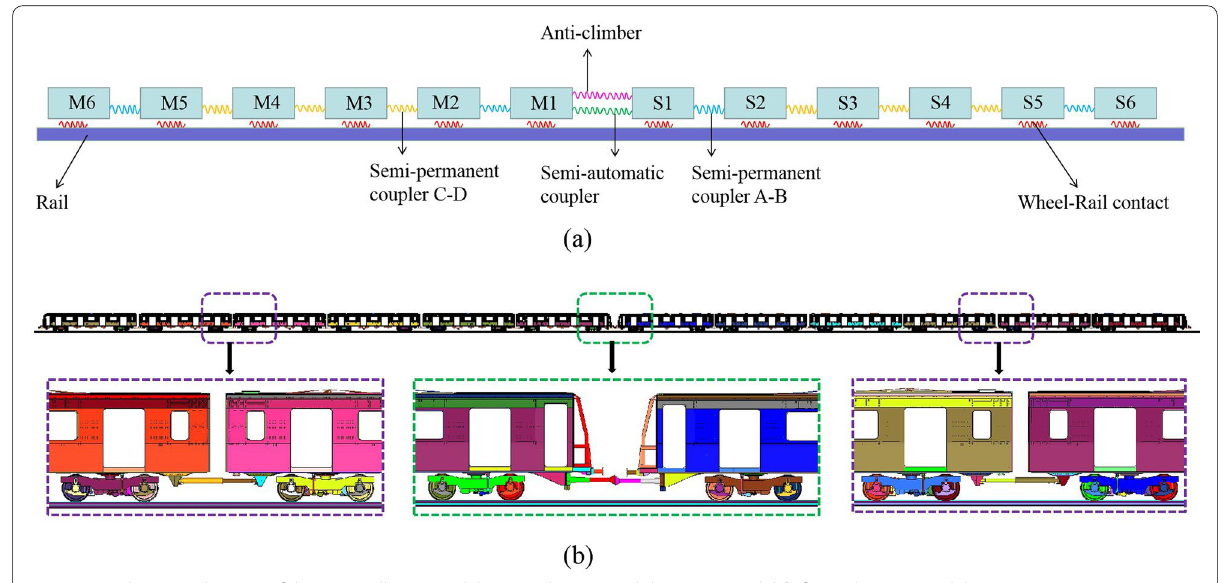
Figure 3 Schematic diagram of the train collision model: a one-dimensional dynamics model, b finite element